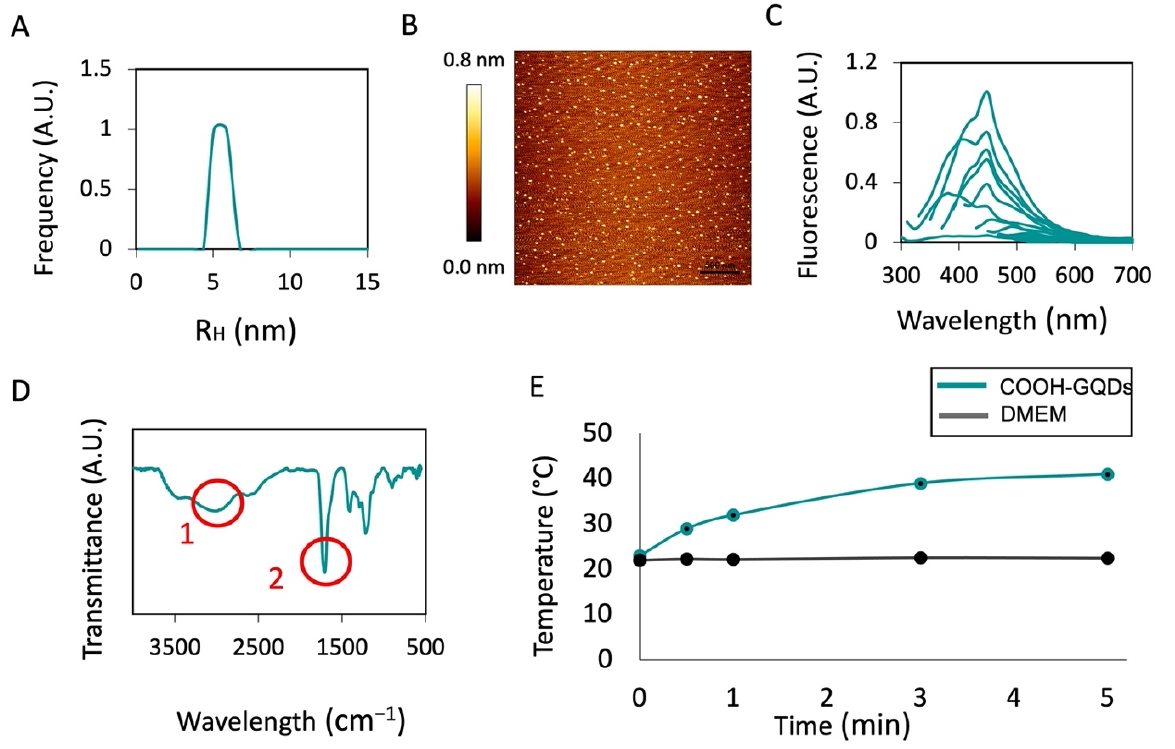
Figure 2. Characterization of GQDs. The hydrodynamic radius of the nanoparticles by DLS ( A ). AFM imaging of GQDs ( B ) with a scalebar of 500 nm. Fluorescence emission spectra of carboxylated GQDs from 300 to 700 nm after excitation wavelengths ranging from 260 to 600 nm ( C ). Data are normalized by maximum excitation. FTIR spectroscopy of GQDs indicating the presence of O-H (red circle 1) and C=O stretching (red circle 2) ( D ). Photothermal conversion of GQDs during a time of 5 min, with an 808 nm laser excitation at a power density of 6 W/cm 2 . DMEM medium has been used for comparison ( E ).